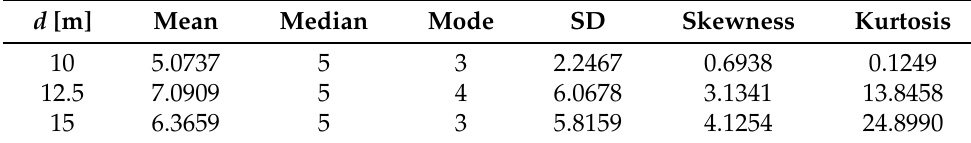
Table 2. Measures of central tendency of freeze lengths in number of frames.